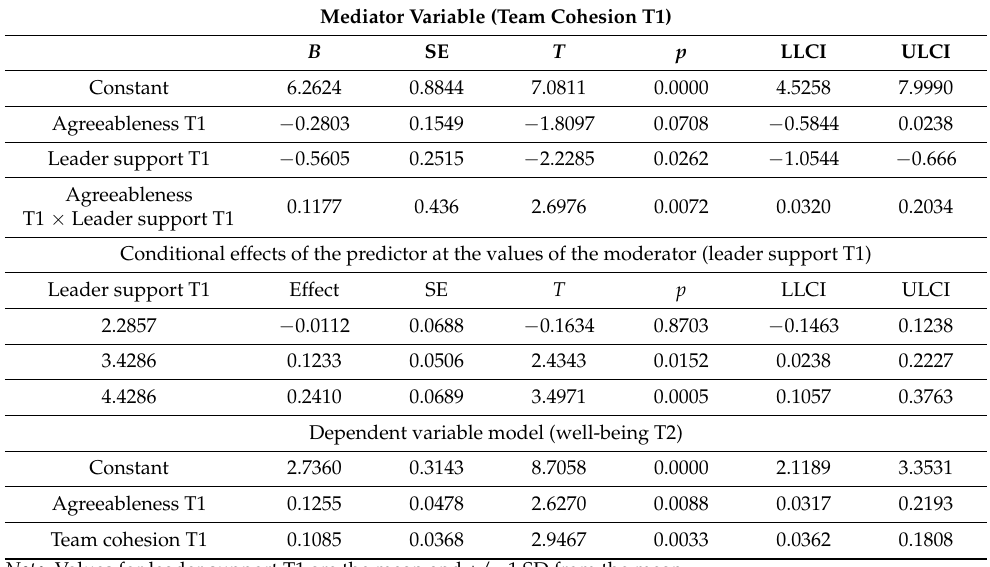
Table 2. Moderated mediation model.